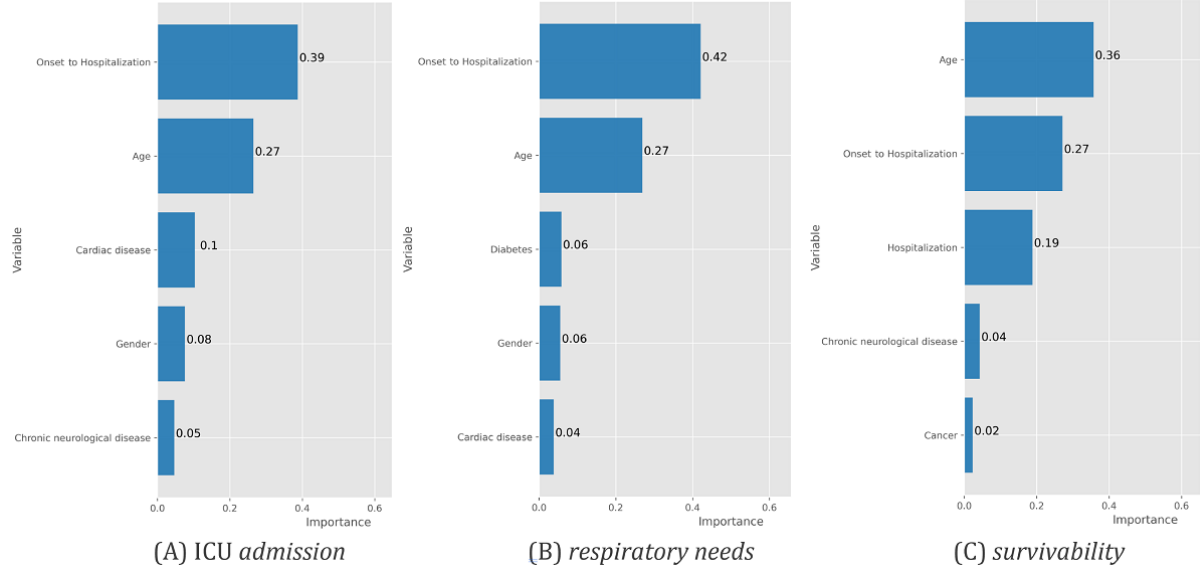
Figure 12. XGBoost top features and their importance for the different outcomes at posthospitalization. ICU: intensive care